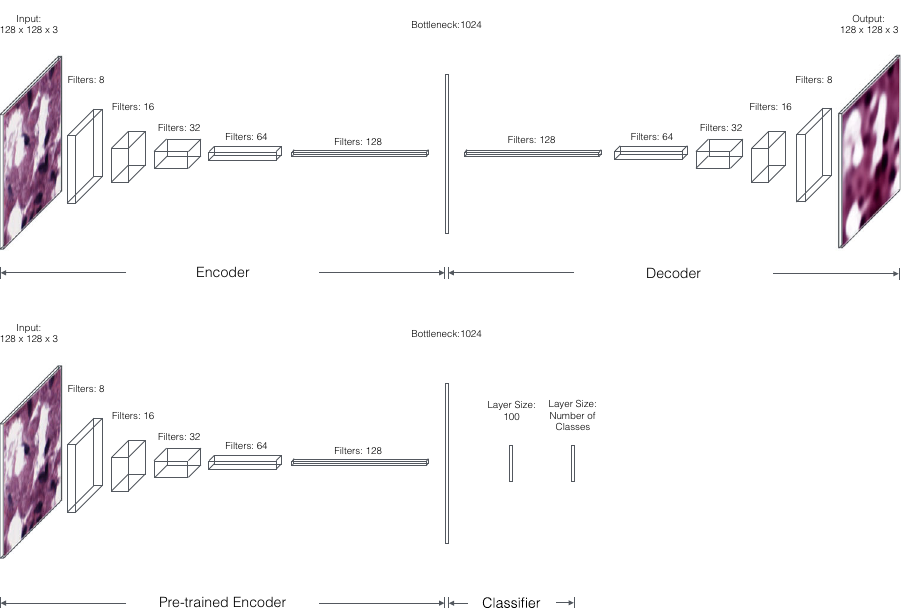
Fig. 6 Architecture of the CAE. Each convolutional layer of the encoder includes 5 × 5 fi lters followed by 2 × 2 max pooling and recti fi ed linear (ReLU) activations. The fi nal convolutional layer of the encoder is fully connected to a layer of 1024 units to produce our embedding. Each convolutional layer in the decoder is upsampled 2× before again applying ReLU nonlinearities. The fi rst convolutional layer of the decoder is linearly projected and reshaped from the bottleneck layer. Bottom: Architecture of the CAE including a multilayer perceptron. The pre-trained encoder is attached to two fully connected layers to allow label classi fi cation. The fi rst classi fi cation layer features 128 ReLU units, and the second has as many neurons as there are classes with softmax activation (for multi-class problems) or a single sigmoid unit (for binary classi fi cation